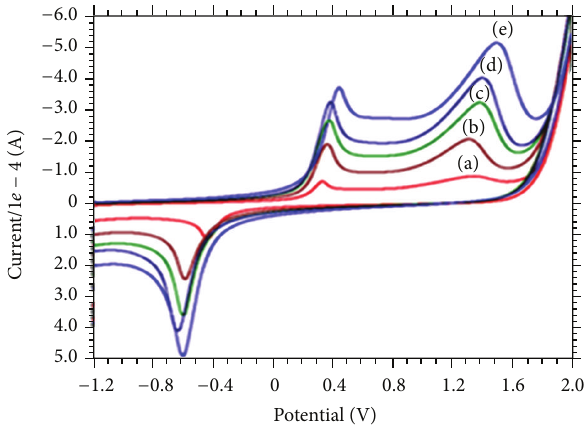
Figure 4: Cyclic voltammograms of 1.0mM 2-thiouracil on GCE with different scan rates at (a) 50, (b) 100, (c) 150, (d) 200, and (e) 250 mVs −1